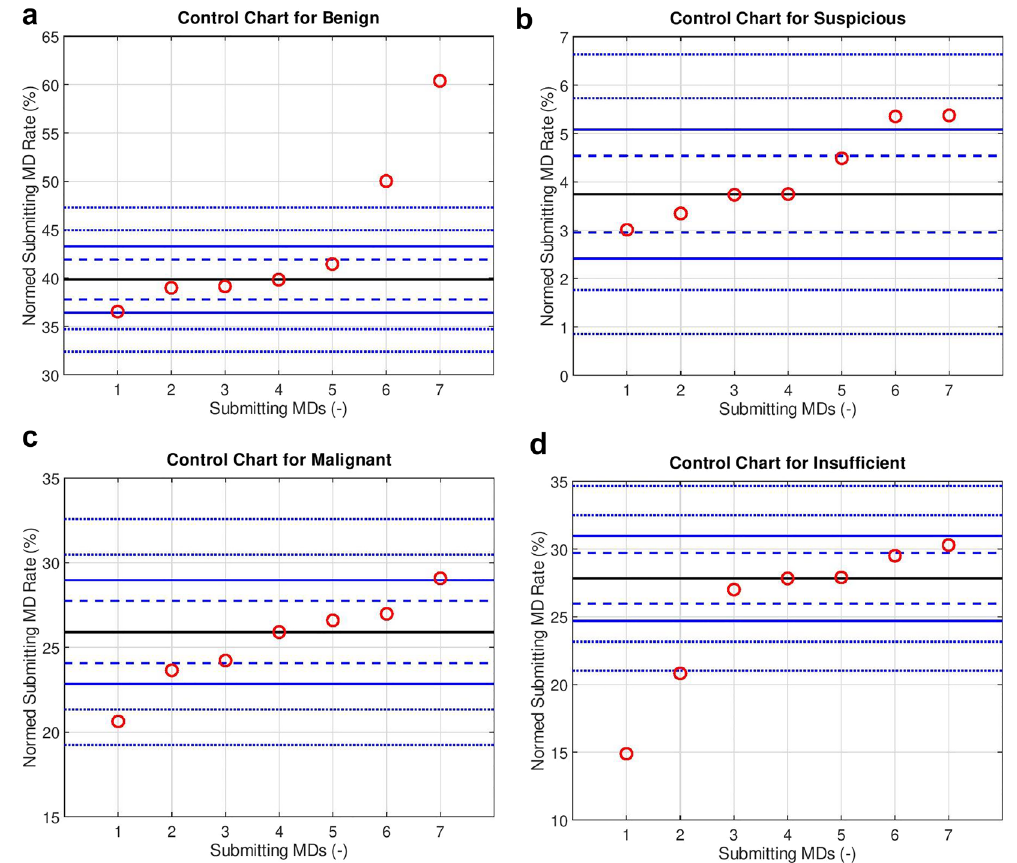
Figure 2. Submitting MD control charts for the mutually exclusive diagnostic categories (( a ) benign, ( b ) suspicious, ( c ) malignant, and ( d ) insufficient). The red circles represent individual submitting MDs. Submitting MDs are ordered by the normalized rate. The black line in the centre of the control chart is the group median rate (GMR). The dashed blue (control) lines represent the boundaries of the 95% confidence interval (CI) and correspond to p = 0.05. The solid blue (control) lines represent the boundaries of the 99.9% CI and correspond to p = 0.001. The dashed blue (control) lines beyond the solid blue line represent the p = 1e-6 and p = 1e-12 respectively. Details of the normalization are in Appendix A. It should be noted that: each control chart is sorted by the rate; submitting MD #1 on one chart is generally not submitting MD #1 on any other